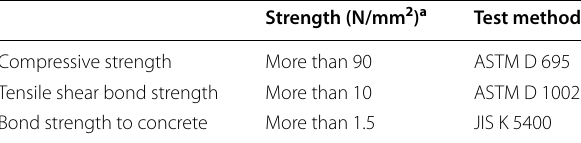
Table 2 Strength properties of